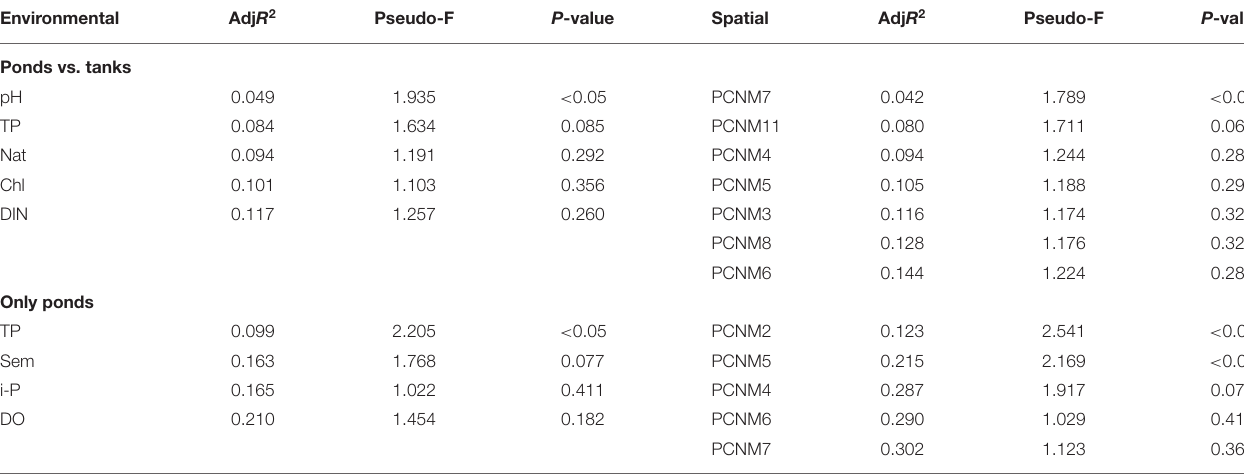
TABLE 3 | Partial effects of the explanatory variables ( Environmental ) and the spatial descriptors based on PCNMs ( Spatial ) using distance-based linear models (DistLM), performing a forward stepwise process based on the Adjusted R 2 ( AdjR 2 ). Environmental Adj R 2 Pseudo-F P -value Spatial Adj R 2 Pseudo-F P -value Ponds vs. tanks